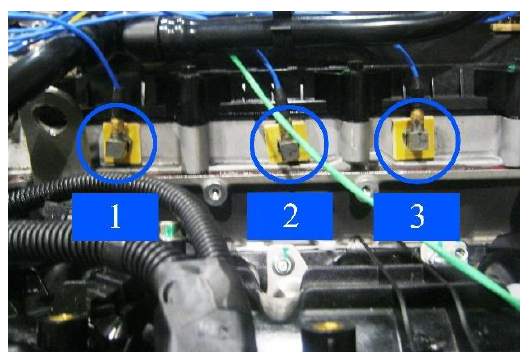
Figure 19. The positions of the acceleration sensors in the vibration experiments.